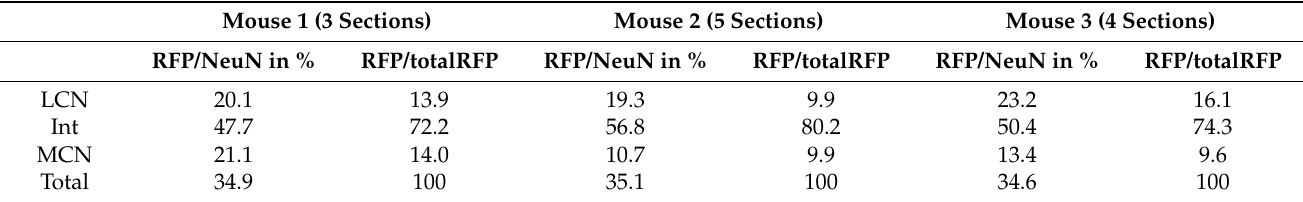
Figure 1. Example of NeuN and RFP staining in adult CN. ( A ) 20 × tilescan of a coronal P48 cerebellar slice, zoomed in on the left CN. Stainings: red fluorescent protein (RFP) in red, NeuN in green, yellow indicating colocalization of these two stainings. ( B – D ) Zoom in of boxed region in ( A ). ( B ) NeuN stained cells. ( C ) RFP-stained cells and fibers. ( D ) Merge of B and C. Note that the RFP + neurons are relatively big and all small neurons are RFP − . A bar plot representation of the quantification of RFP + cells as a proportion of NeuN + cells (N = 3 mice). Scale bars: ( A ) = 150 µ m, ( B – D ) = 25 µ m. CN = cerebellar nuclei, MCN = medial cerebellar nucleus, Int = interposed nucleus, LCN = lateral cerebellar nucleus. Table 4. Relative amount of RFP + neurons (RFP/NeuN in %) per cerebellar nucleus and the rela- tive amount of RFP + neurons in each nucleus compared to the total amount of RFP + CN neurons (RFP/totalRFP in %) for three mice. Data per mouse are averaged from 3 to 5 coronal